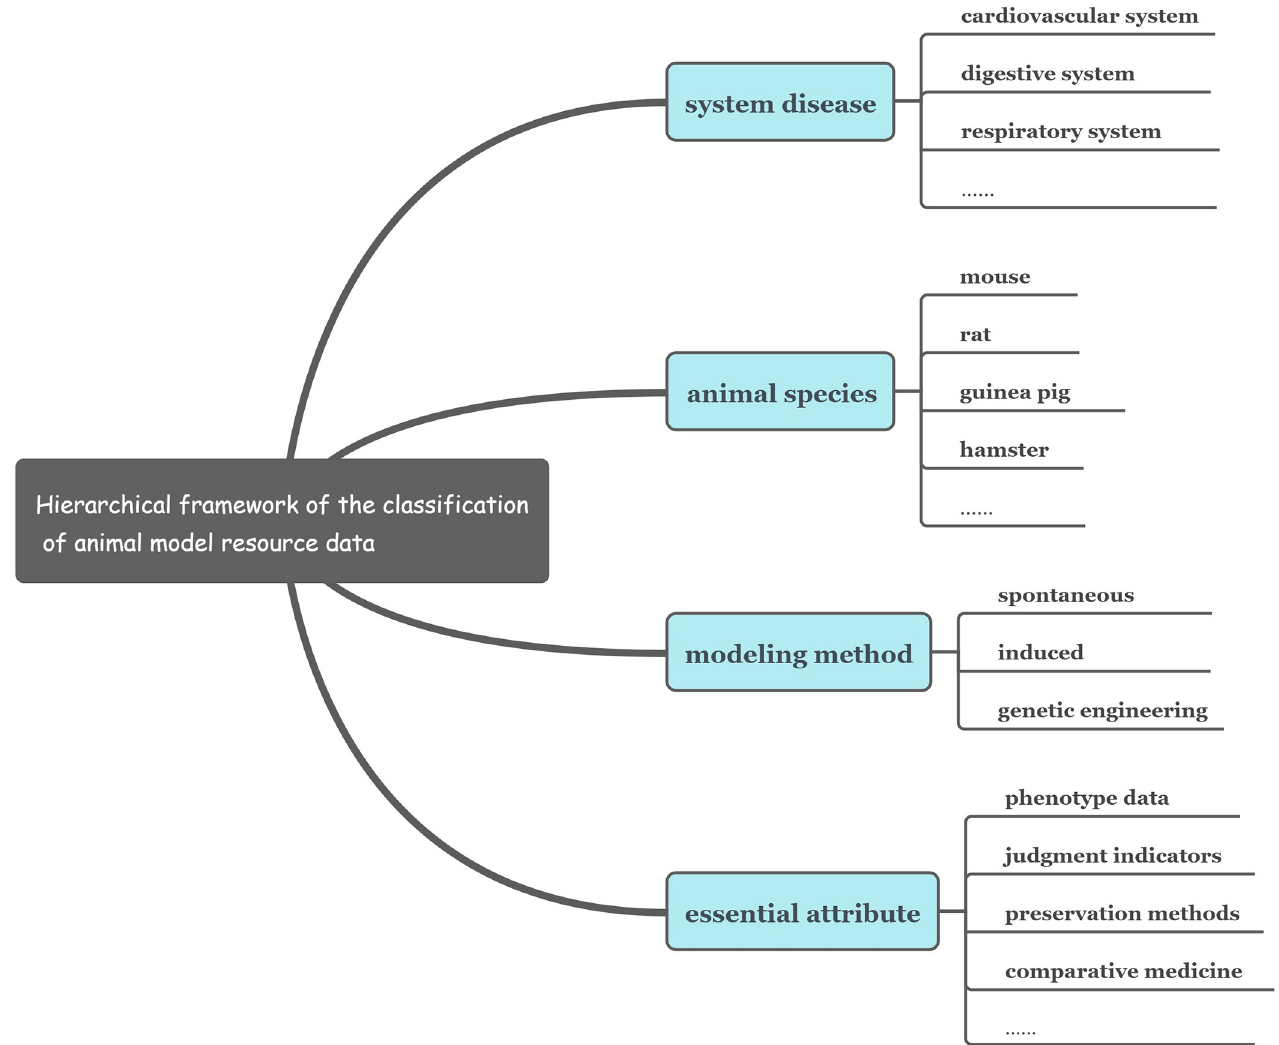
Fig 1. Hierarchical framework of the classification of animal model resource